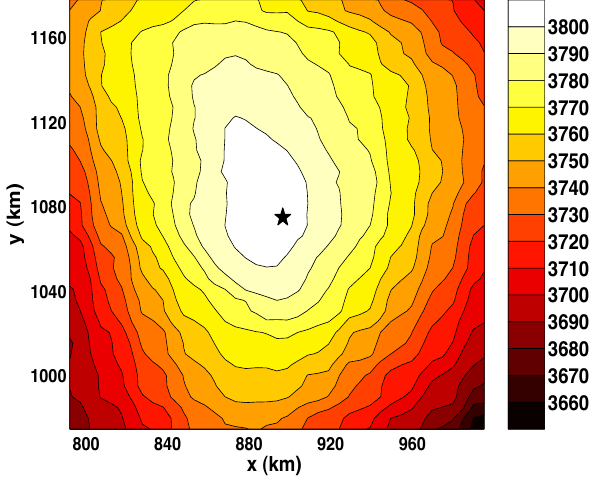
Fig. 3. Bedrock topography in the model domain (in ma.m.s.l., contour spacing 100m). The black star indicates the location of the Dome Fuji drill site, north is towards the top right (see Fig.